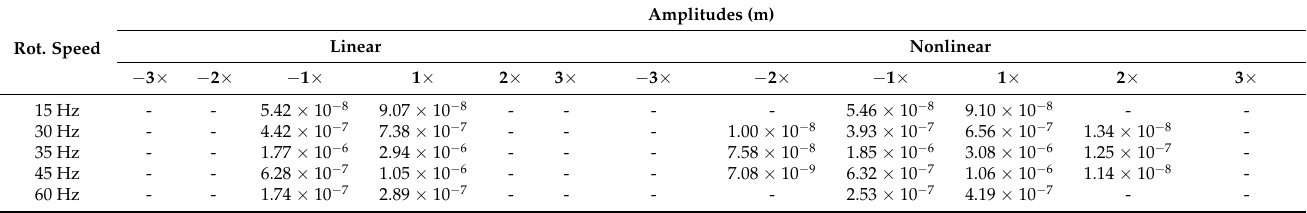
Figure 10. DFT full spectrum of simulated results in elliptical bearing 1 (preload 0.8): ( a ) linear, ( b ) nonlinear. Table 2. Magnitudes of the most relevant peaks of Figure 10—elliptical bearing (preload